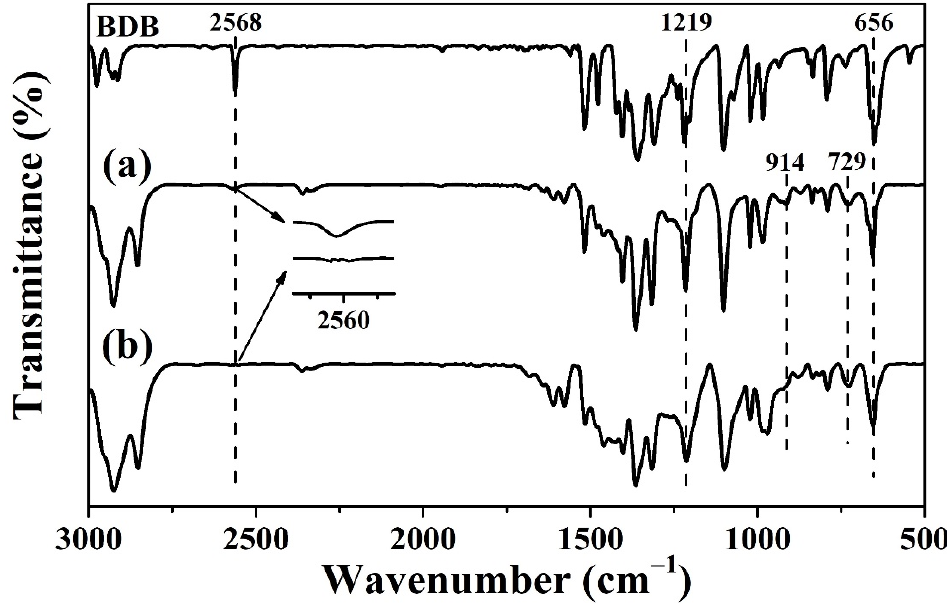
Figure 3. FTIR spectra of OBZ-BDB before ( a ) and after ( b ) curing.